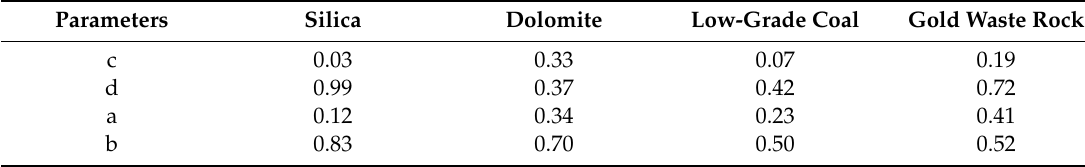
Table 2. Parameters obtained for the di ff erent materials.